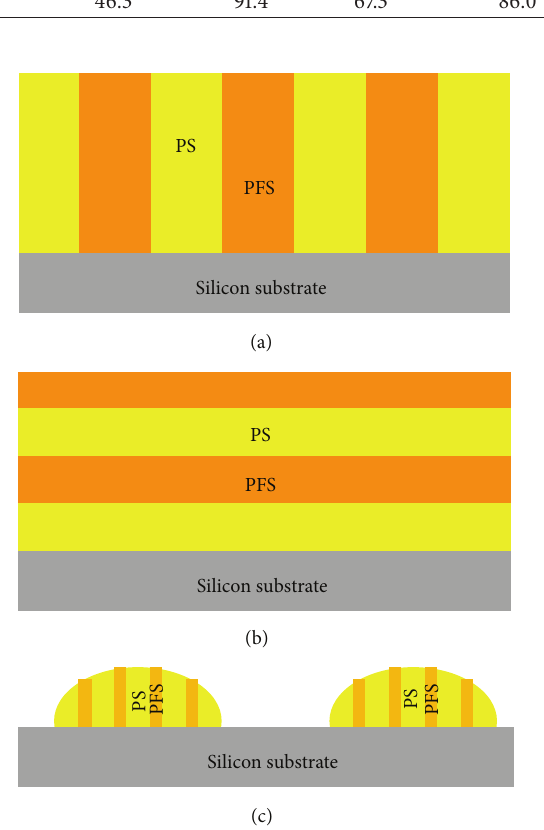
Scheme 2: Schematic of the effect the polymer/substrate interaction can have on film morphology: (a) both blocks have an affinity for the surface, (b) one block preferentially wets the surface, and (c) both blocks are repulsed by the